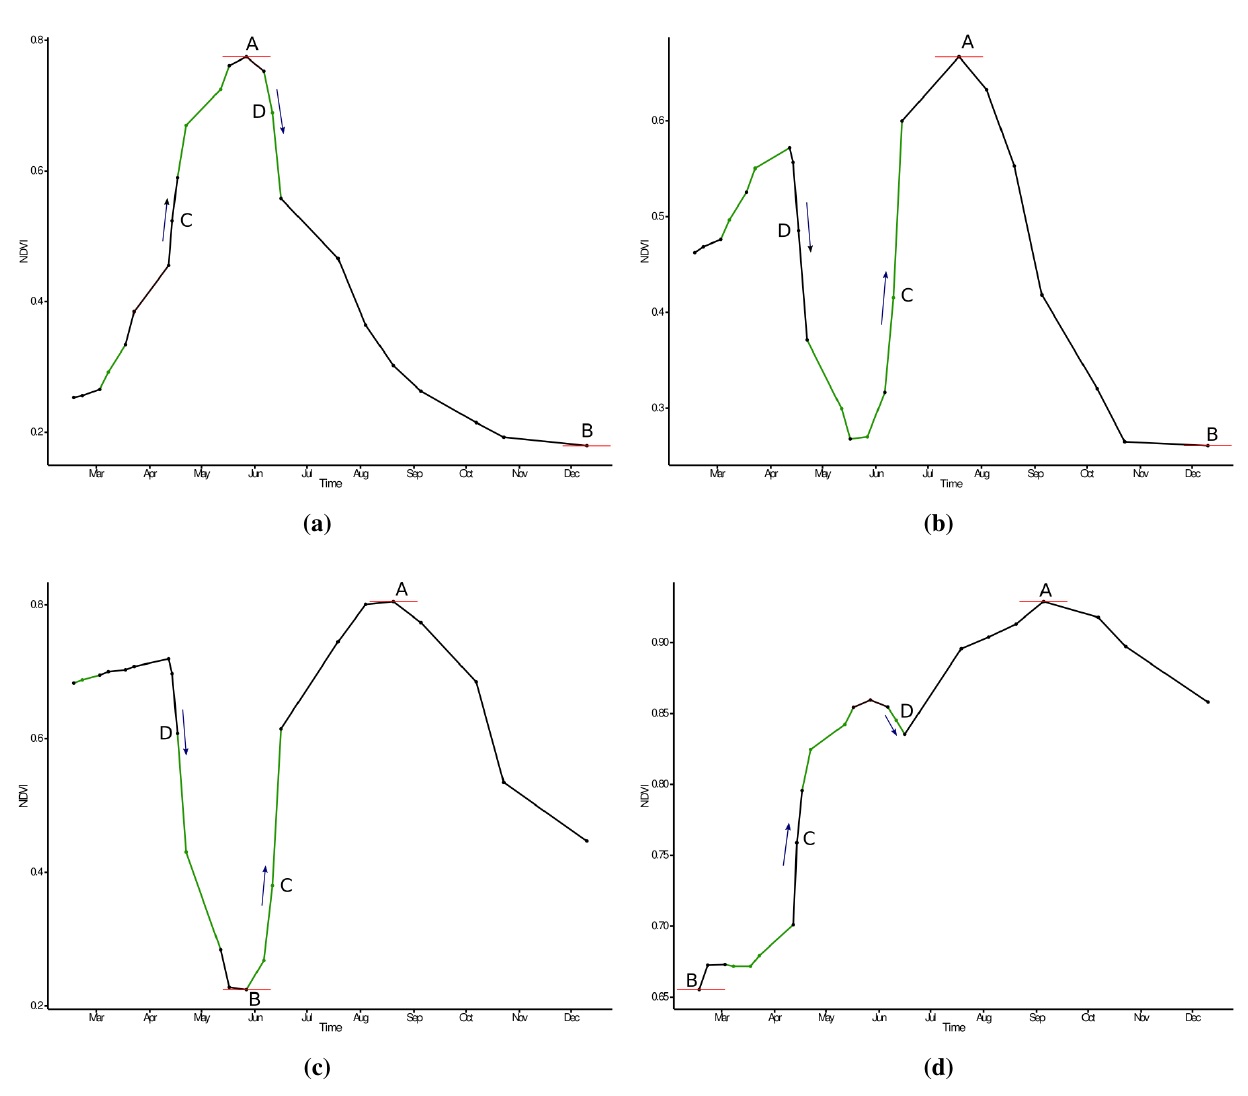
Figure 3. Temporal NDVI profile for crop surfaces ( a , b ), grassland surface ( c ) and forest ( d ), all located in France with dates where interpolated reflectances were used to compute the NDVI (green dots and lines) and temporal features (A: maximum value of NDVI; B: minimum value of NDVI; C: maximum slope; D: minimum